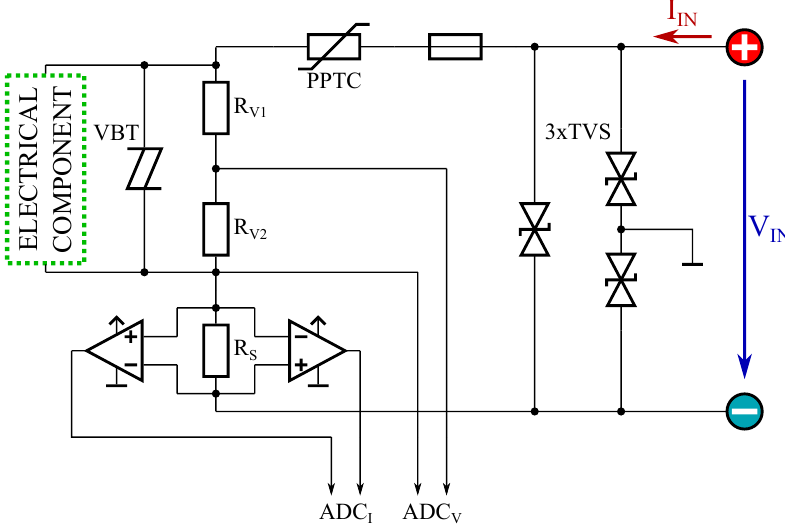
Figure 1. Circuitry of the voltage and current measurement. For voltage measurement, a voltage divider formed by two precision resistors R V 1 and R V 2 is used to map the applied voltage range to the differential input range of the analog to digital converter (ADC) ADC V . The current measurement is realized by